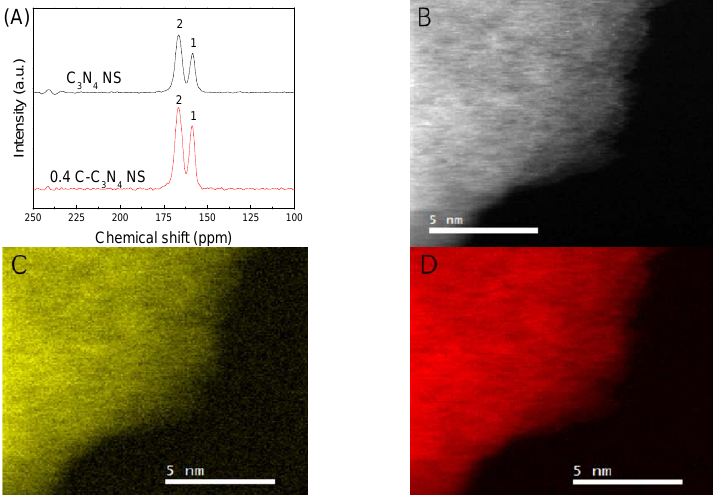
Figure 3. ( A ) Solid ‐ state 13 C ‐ magic ‐ angle spinning (MAS) ‐ NMR spectra of C 3 N 4 NS and 0.4 C ‐ C 3 N 4 NS. ( B ) Electron ‐ energy loss spectroscopy (EELS) mapping of 0.4 C ‐ C 3 N 4 NS for merged mapping,